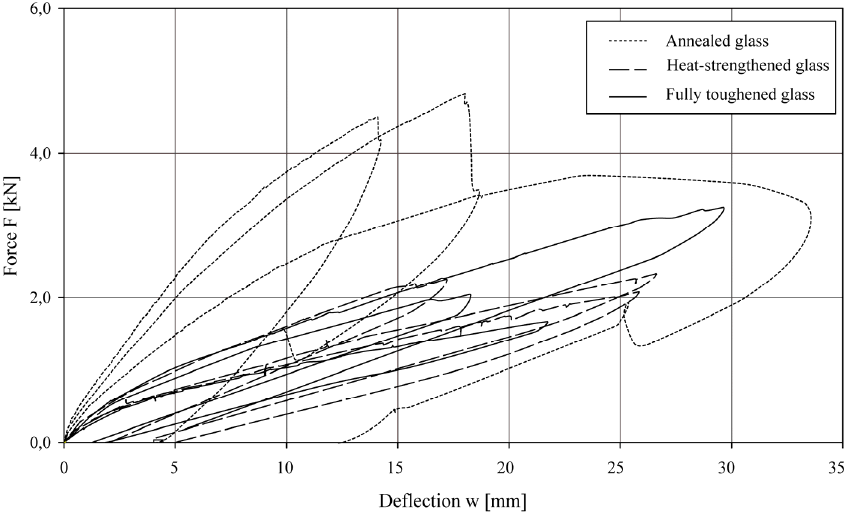
Figure 8: Load-deflection curves of composite beams manufactured with annealed glass, heat-strengthened glass and fully toughened